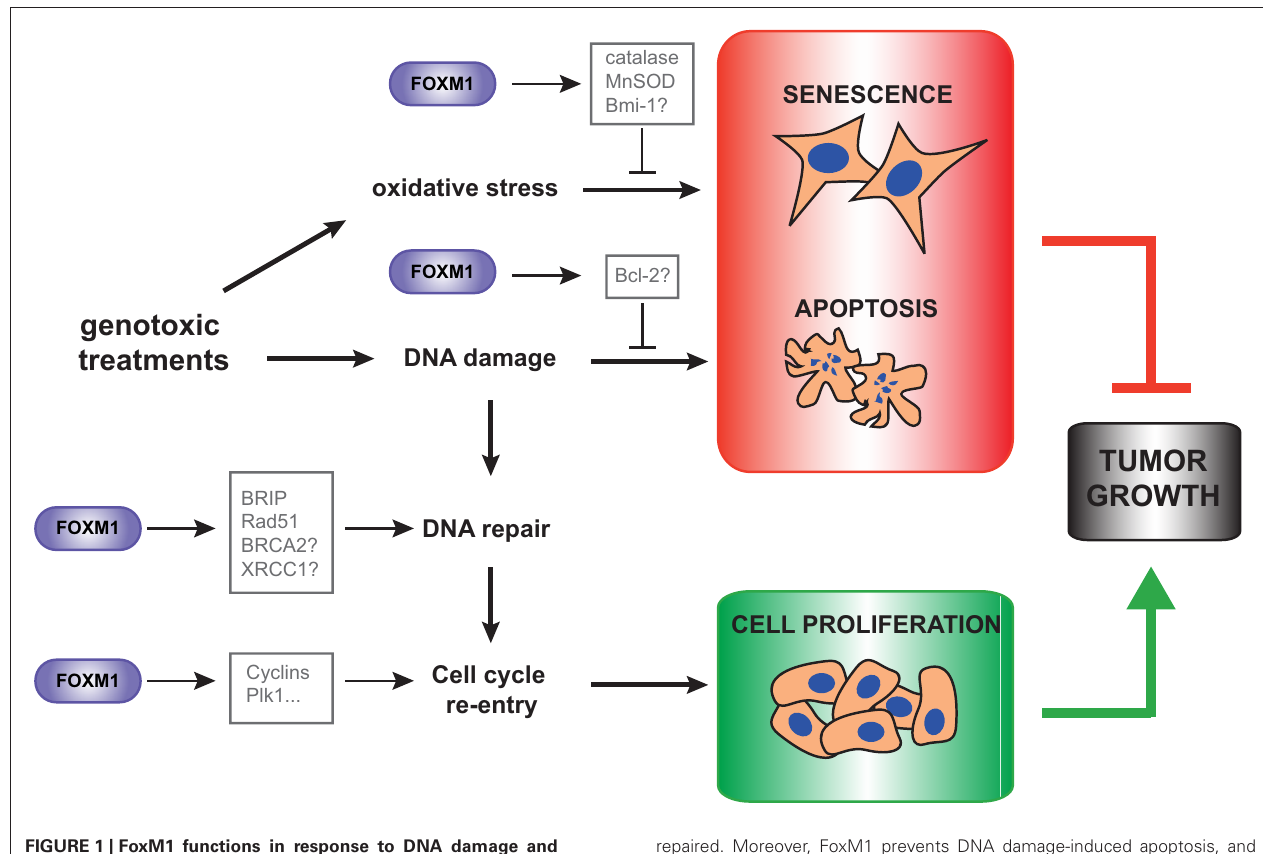
repaired. Moreover, FoxM1 prevents DNA damage-induced apoptosis, and protect cells from oxidative stress-induced senescence. These FoxM1 functions favor tumor growth, and open different possibilities of targeting FoxM1 in cancer